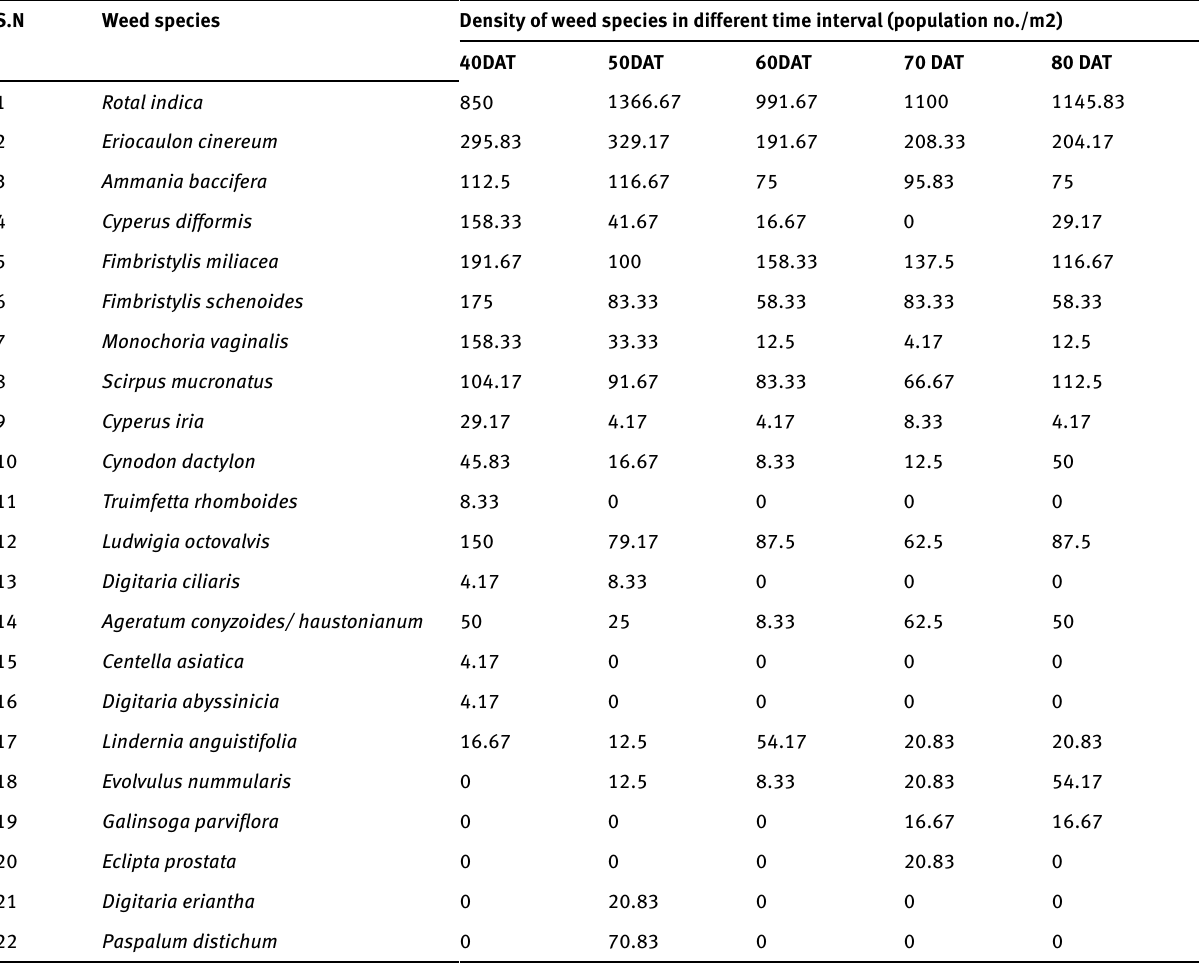
Table 5 : Density of different weed species during different time interval during rice crop period at Sunadarbazar, Lamjng in 2016